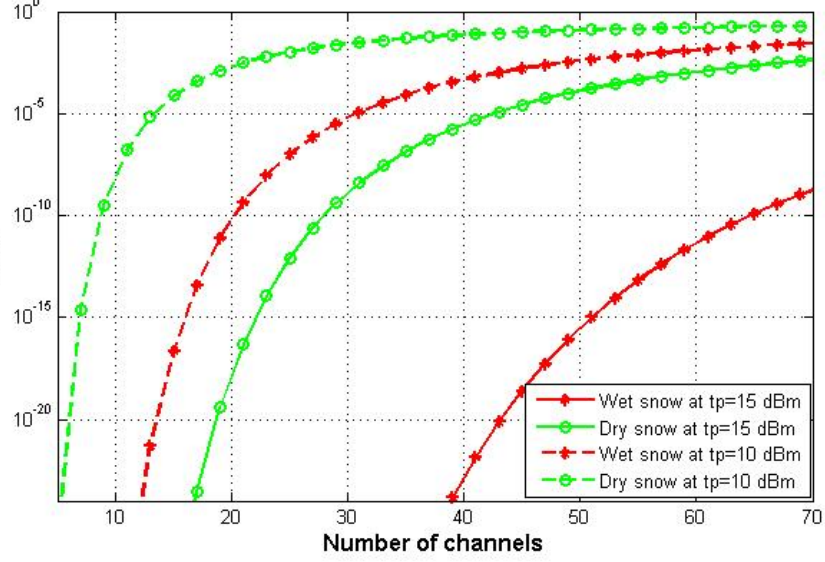
Figure 11. BER of FSO-PDM/PV-OCDMA system versus number of channels under snowy condi- tions.